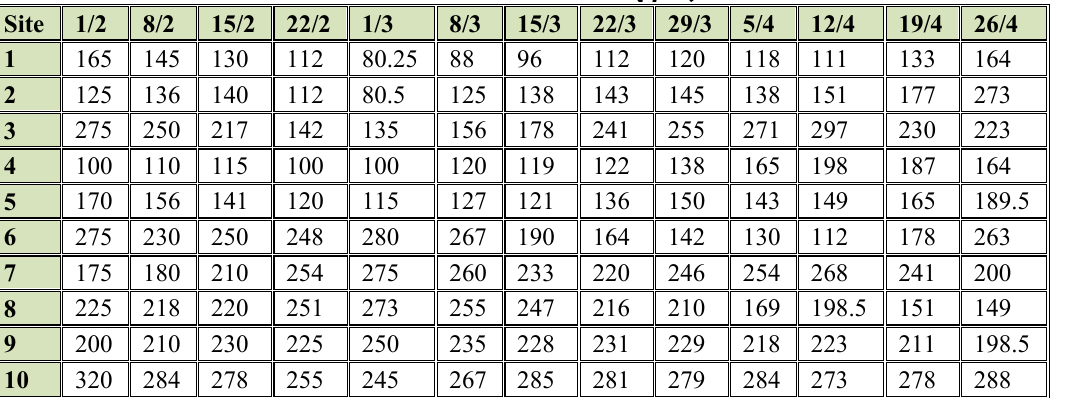
Table 5: Chlorides values (ppm).